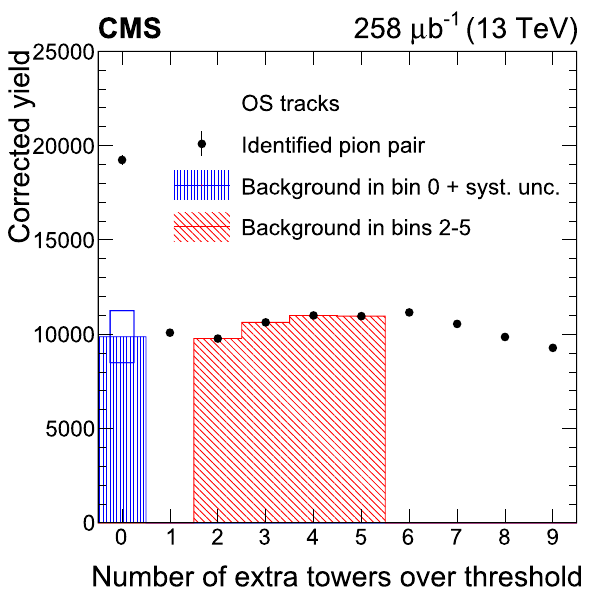
distribution, which is denoted by the blue hatched area. The error bars correspondtostatisticaluncertainties,whereastheerrorrectangleonthe background denotes the 14% systematic uncertainty in the background normalization. Plots are similar for 5.02TeV data